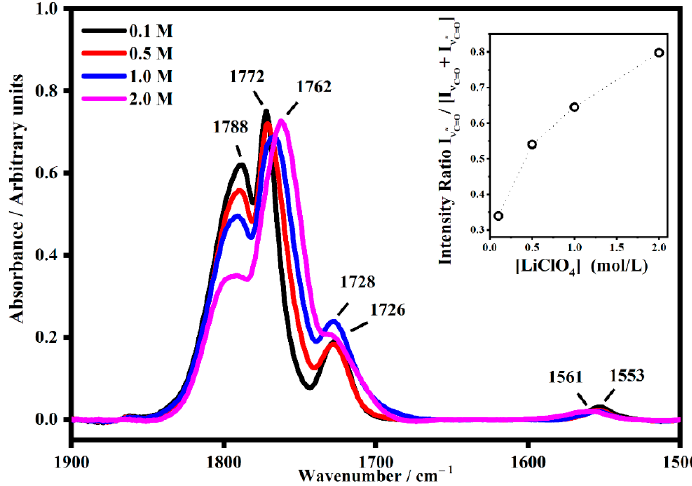
Figure 11. The IR band assigned to the C=O mode of free EC and PC carbonate denominated ν C=O (~1788 cm − 1 ) and its satellite band at ν C=O* (~1772 cm − 1 and ~1762 cm − 1 ) in PMMA-Li-PC-EC gel polymer electrolyte at different salt concentrations: 0.1 M, 0.5 M, 1 M and 2 M. In the inset, the trend of the intensity ratio I ν C=O* /[I ν C=O + I ν C=O* ] as a function of the salt concentrations.